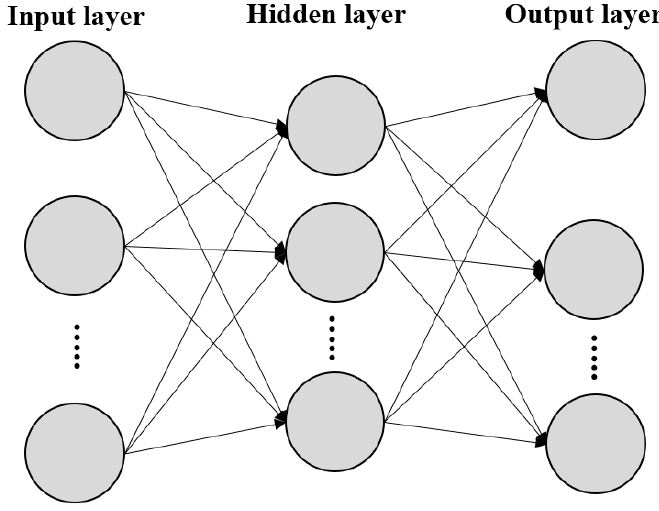
Figure 4. Structure of the MNN.